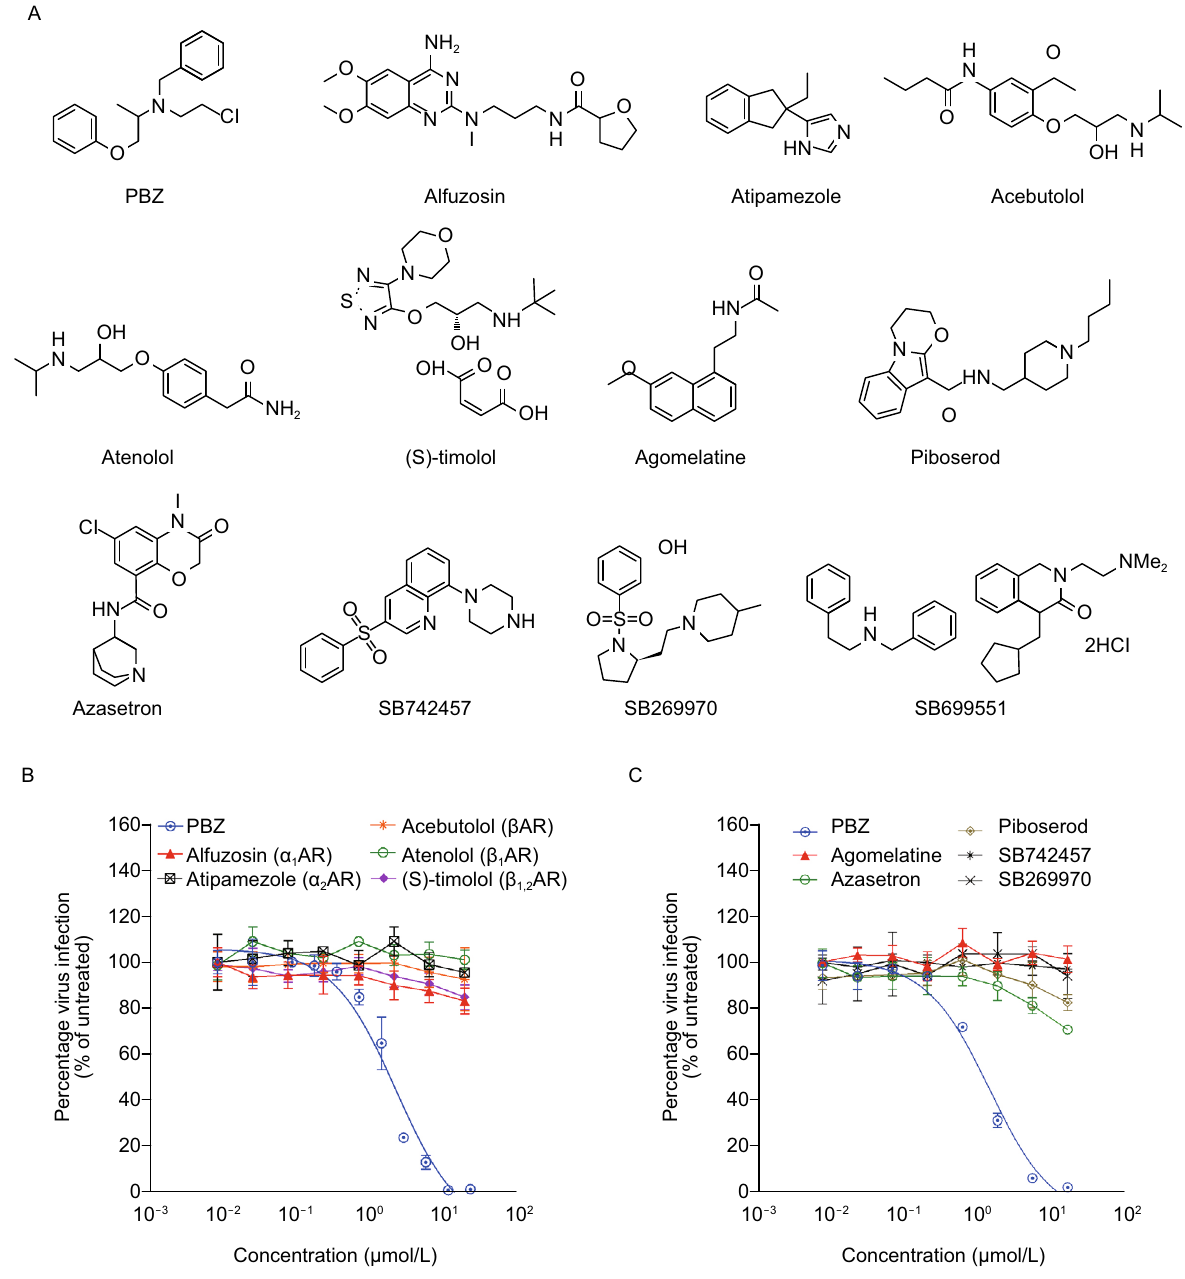
Figure 1. Chemical probes help to identify the antagonism of 5-HT 2A R inhibiting HCVcc. (A) Chemical probes are composed by a subset of selected FDA-approved adrenergic receptors and serotonin receptors antagonists. (B and C) The HCV inhibition of all chemical probes. Huh7.5.1 cells infected by HCVcc were treated with various adrenergic receptors antagonists (B) and serotonin receptors antagonists (C) at the indicated concentrations at 37 °C for 48 h. The infections are quanti fi ed by qRT-PCR measuring virus RNA. All results are graphed as the mean ± SD for triplicate